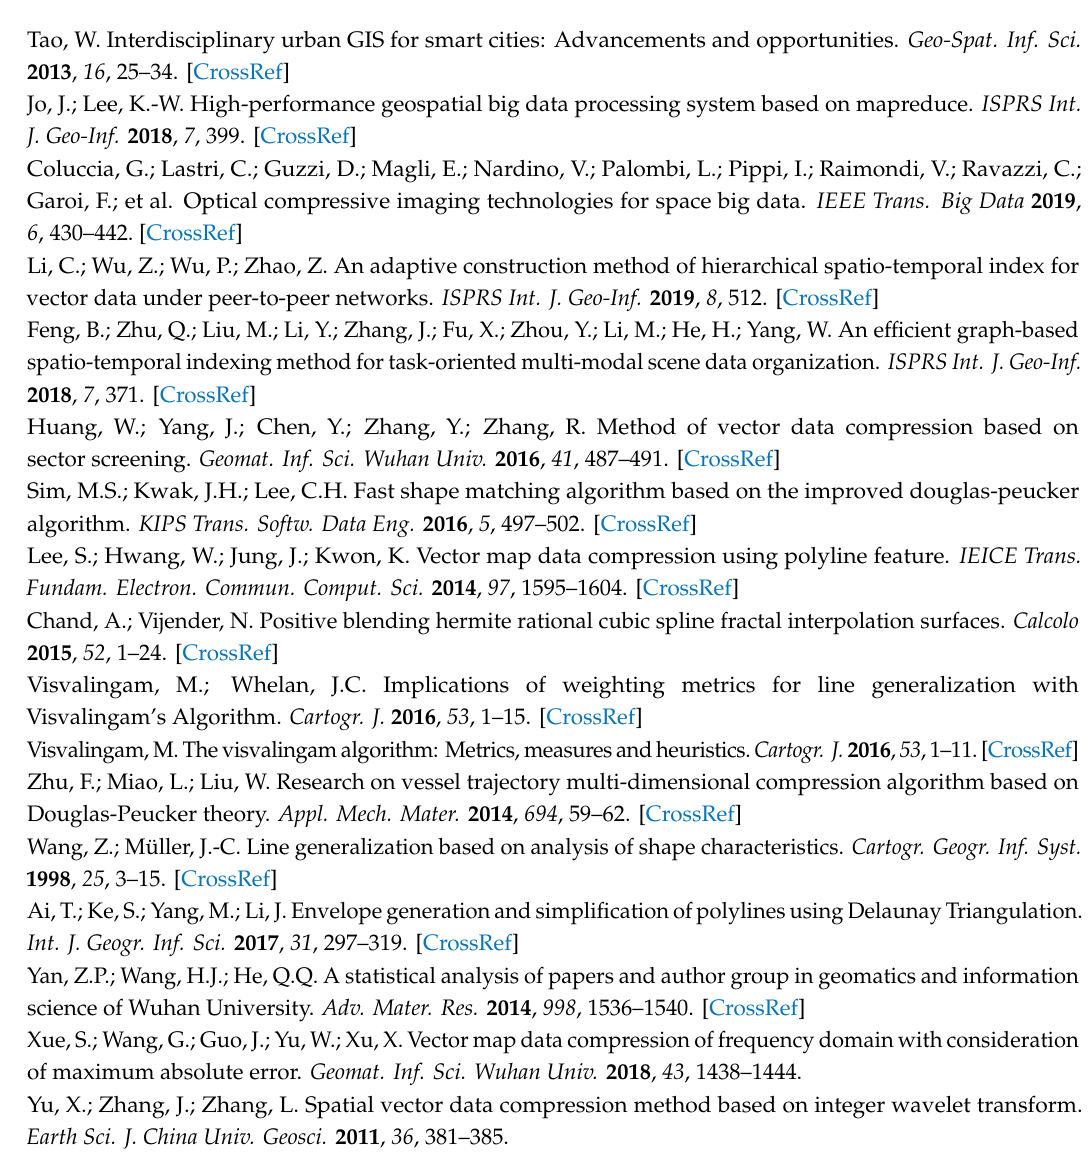
Figure S1: Test dataset 1: LRDL layer, Figure S2: Test dataset 2: RESP layer, Figure S3: Test dataset